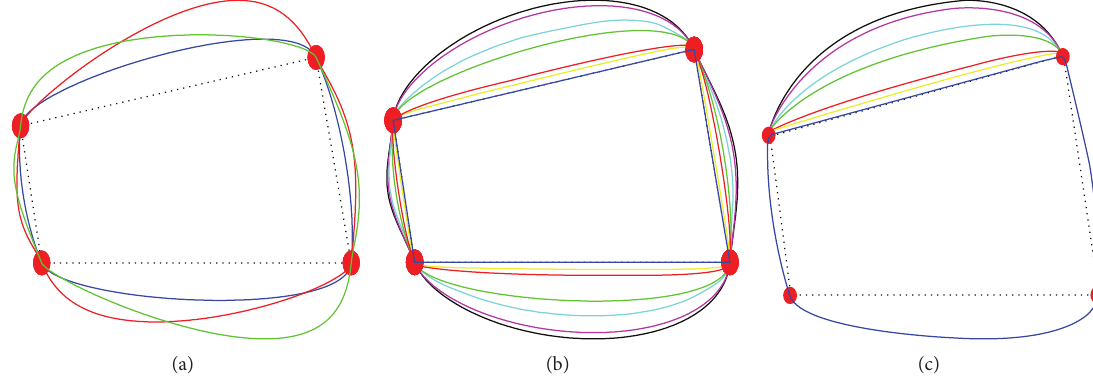
Figure 8: Rational spline interpolants: (a) effect of parameters; (b) global interval tension property; (c) local interval tension